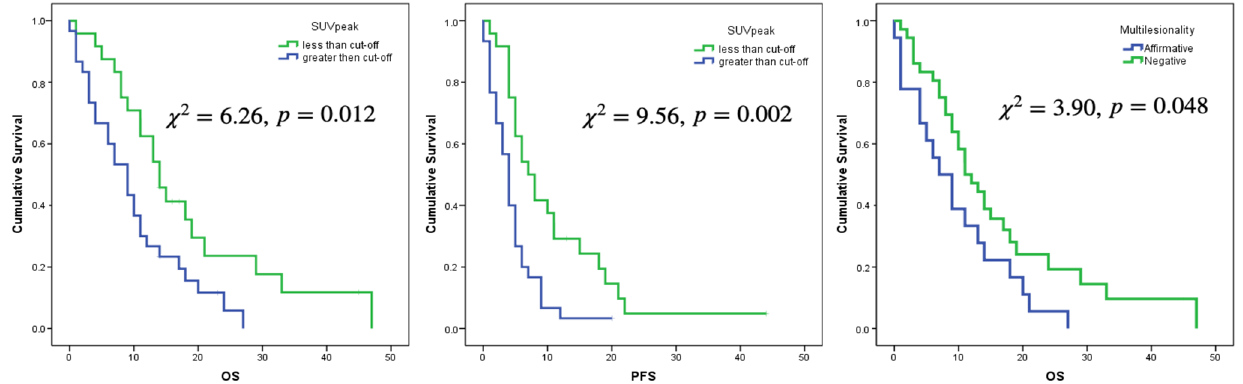
Figure 4. Log Rank curves for OS and PFS for a cut-off value of SUVpeak of 2.5 and for OS regarding multilesionality or not on 18 F-Fluorocholine PET images.